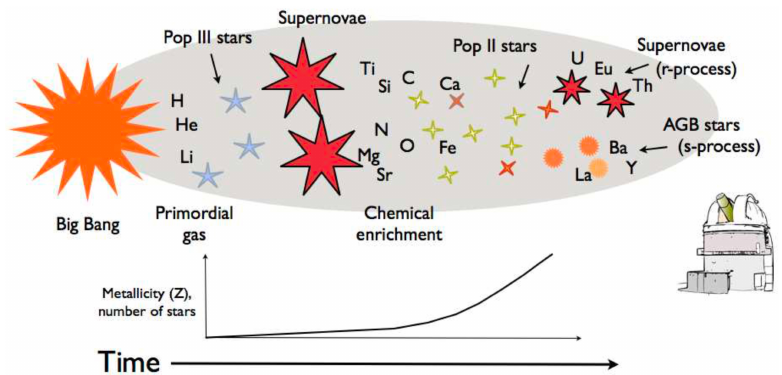
Figure 1. Conceptual illustration of chemical enrichment of the universe: cycles of star formations and cataclysmic deaths enrich the universe over time